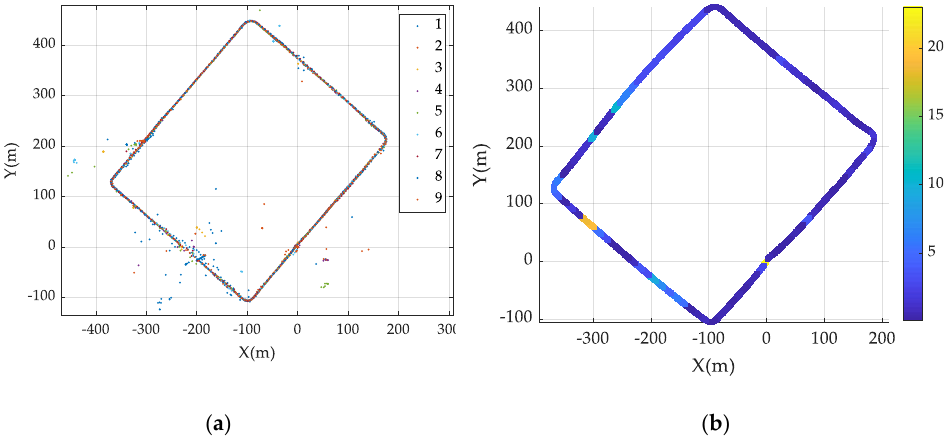
Figure 8. ( a ) GNSS measurement data measured in 9 driving tasks. ( b ) Results of the local characteristic error map generation.